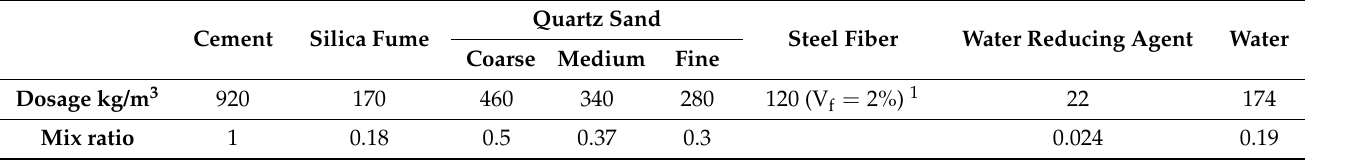
Table 1. RPC test mix